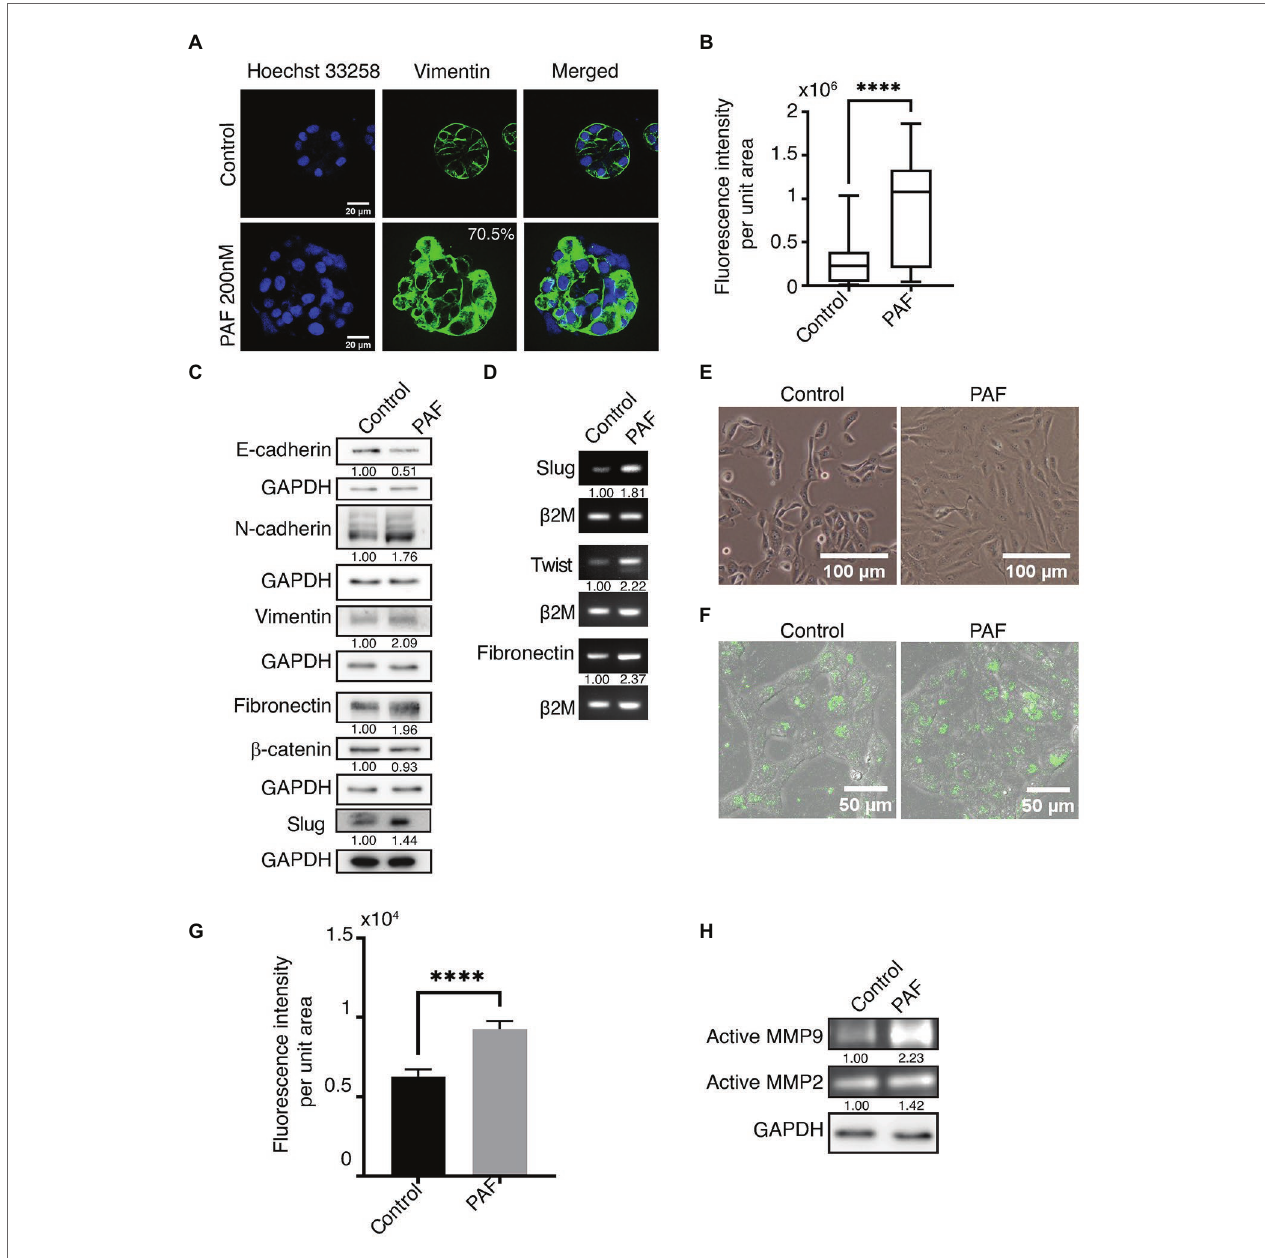
FIGURE 3 | PAF treatment induces partial epithelial-mesenchymal transition (EMT)-like phenotype. MCF10A cells grown for 20 days on Matrigel ™ treated with and without 200 nM PAF immunostained and immunoblotted with EMT markers. (A) PAF-treated acini showed upregulated vimentin expression (green). (B) Box plot depicts the acinar fluorescence (CTCF) of vimentin ( N = 4). (C) 20-day 3D culture lysates of control and PAF immunoblotted for various EMT markers. The values represent fold change with respect to control and normalized to GAPDH ( N = 3). (D) mRNA expression analysis done for various EMT markers using RNA lysates. The values represent fold change with respect to control and normalized to β 2M ( N = 3). (E) Phase contrast images of dissociated cells of PAF treated acini grown as 2D cultures showed a mesenchymal phenotype. (F) Dissociated cells of control and PAF, seeded on rat tail collagen type1 containing DQ ™ collagen type1 and fluorescence intensity captured on SP8 confocal microscope (Leica, Germany). (G) Quantification of the DQ fluorescence per cell ( n = 150). (H) Coomassie-stained gel showing gelatinase activity using conditioned media from 3D cultures. The values represent fold change with respect control and normalized to GAPDH. Statistical analysis was performed for (A) and (F) using Mann Whitney U test; **** p <